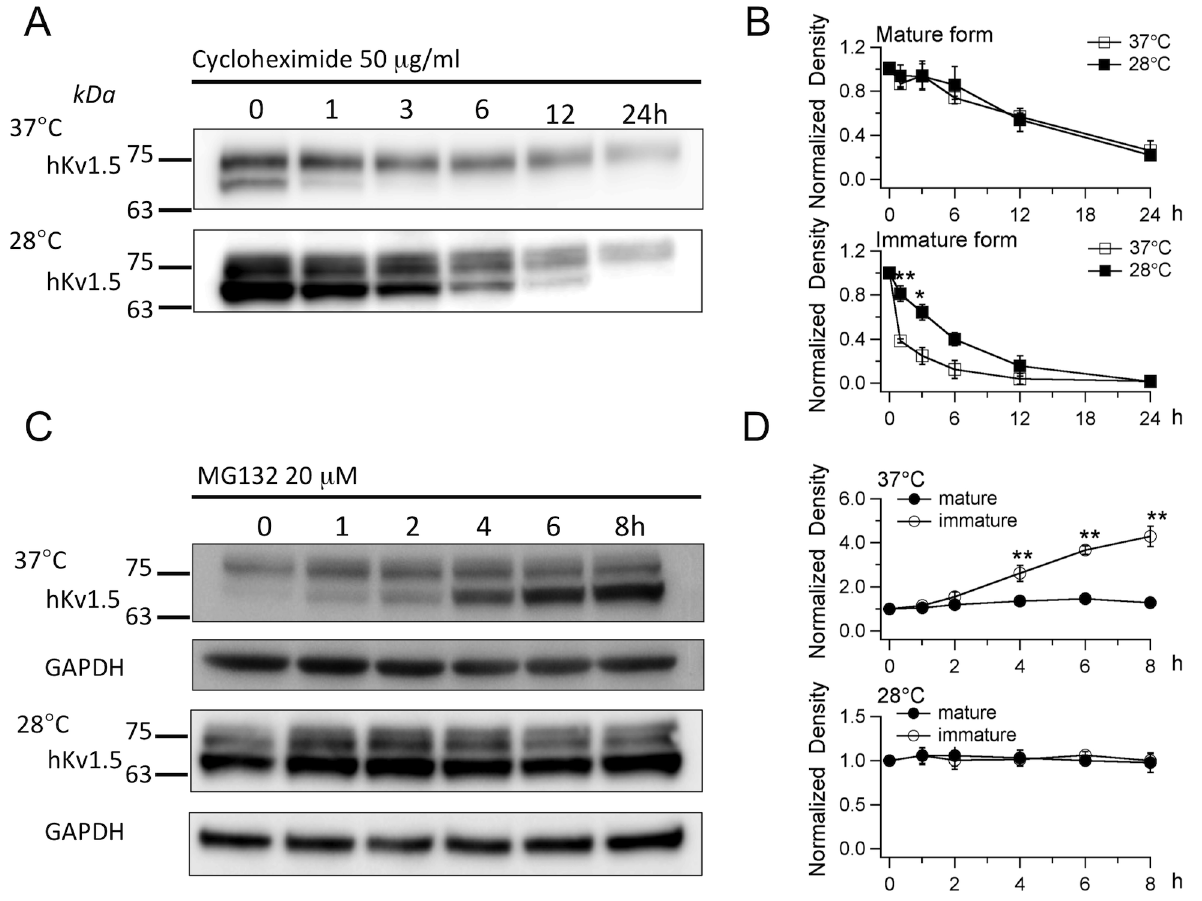
Figure 4. The effects of low temperature culture on the turnover of hKv1.5. (A) Chase analysis of the hKv1.5 expression, cultured at 37 u C or 28 u C for the indicated times after the treatment with cycloheximide, indicating the prolongation of the decay of the hkv1.5 immature protein cultured at low temperature. (B) Quantitative densitometry scans of the time-chase with cycloheximide treatment, cultured at 37 u C or 28 u C (* P , 0.05 vs 37 u C). (C) The expression of hKv1.5 cultured at 37 u C or 28 u C after the treatment with MG132 (20 m M) for the indicated times. (D) Quantitative densitometry scans of the time-chase with MG132 treatment, cultured at 37 u C or 28 u C (** P , 0.01 vs time 0).